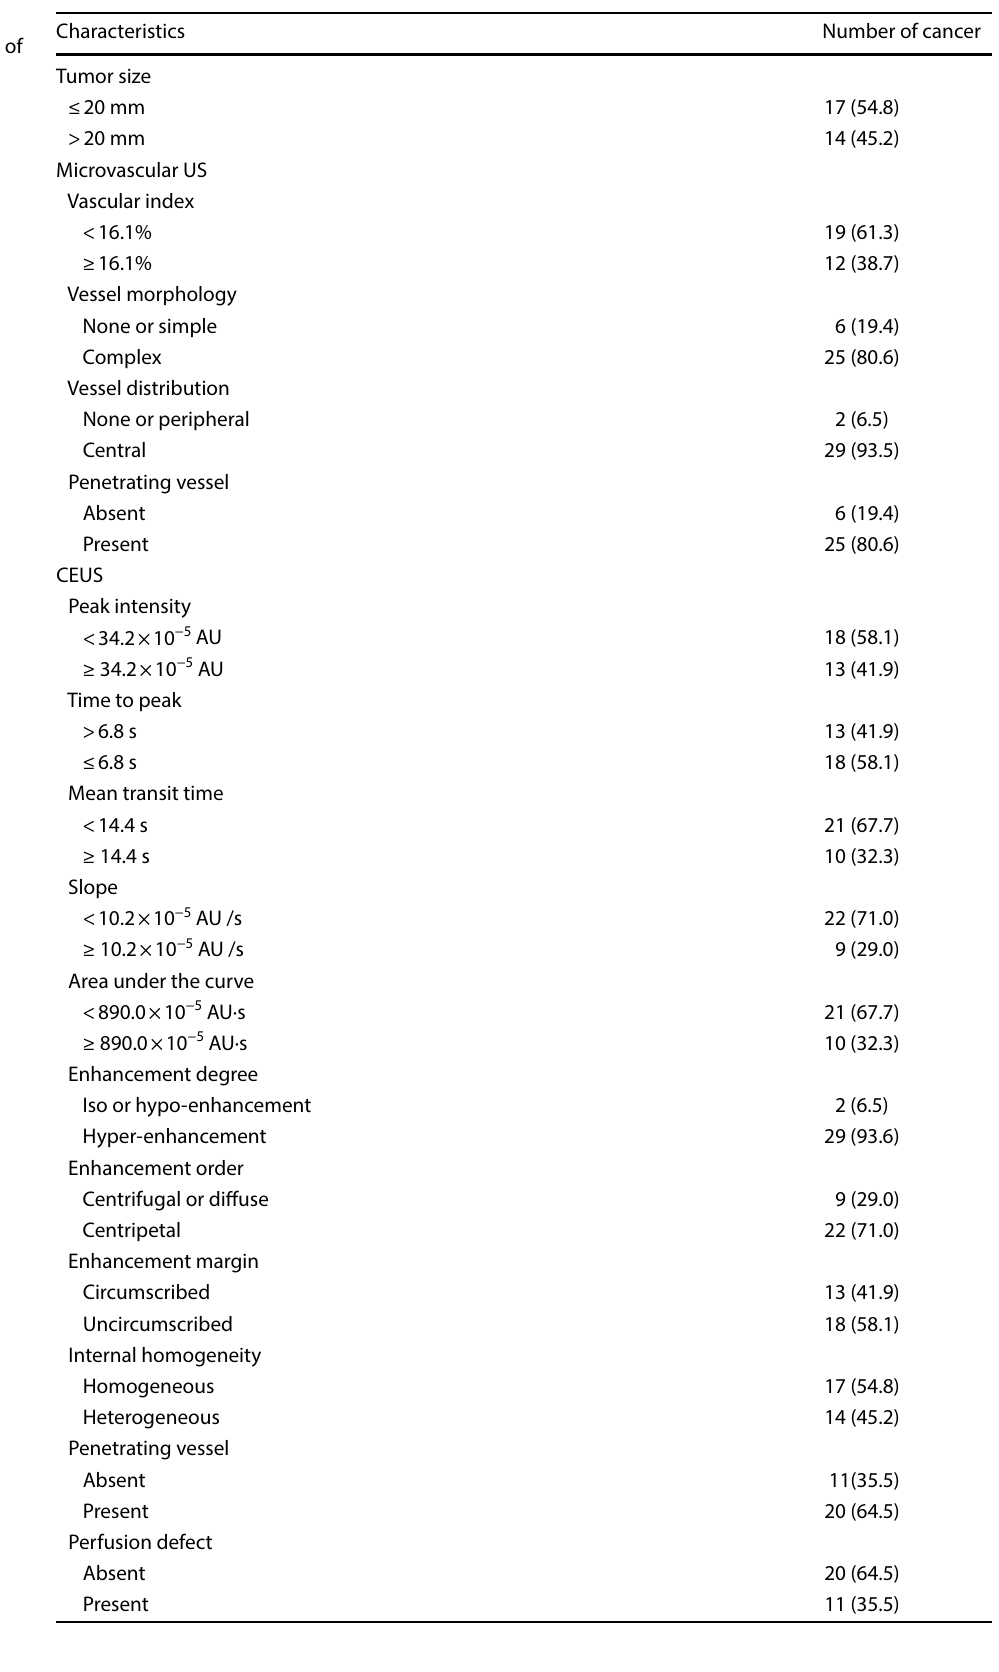
Table 2 The US and pathological characteristics of 31 breast cancer